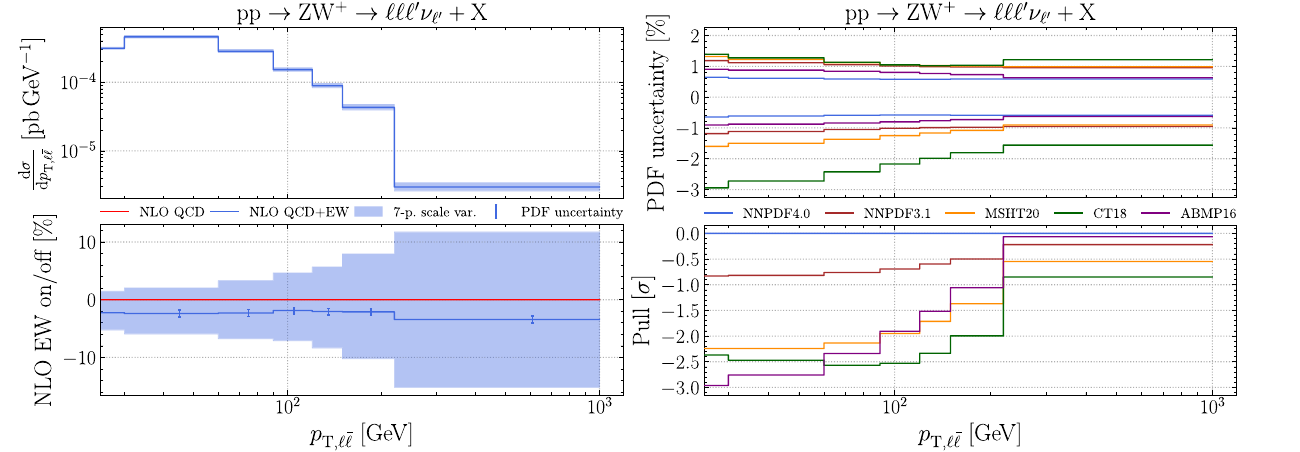
Fig. 67 Same as Fig. 63 for pp → (cid:5) ¯ (cid:5) ¯ (cid:5) (cid:8) ν (cid:5) (cid:8) +